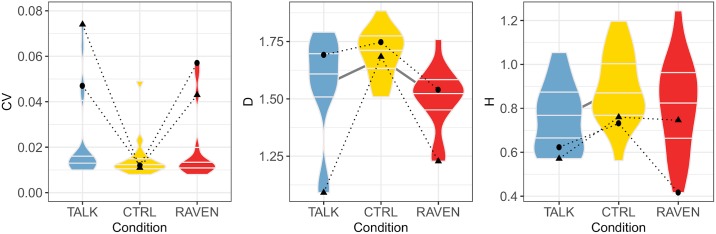
Violin plots of the the variability indicators CV, D and H versus experimental conditions.The maximal and minimal data set the limits of the violin plots, and the median, first and third quartiles are also shown (horizontal bars). Significant differences between two conditions are marked by a gray line linking the concerned violin plots. The behaviour of two participants (3, circles, and 8, triangles) when going from CTRL condition to TALK or RAVEN conditions is displayed.